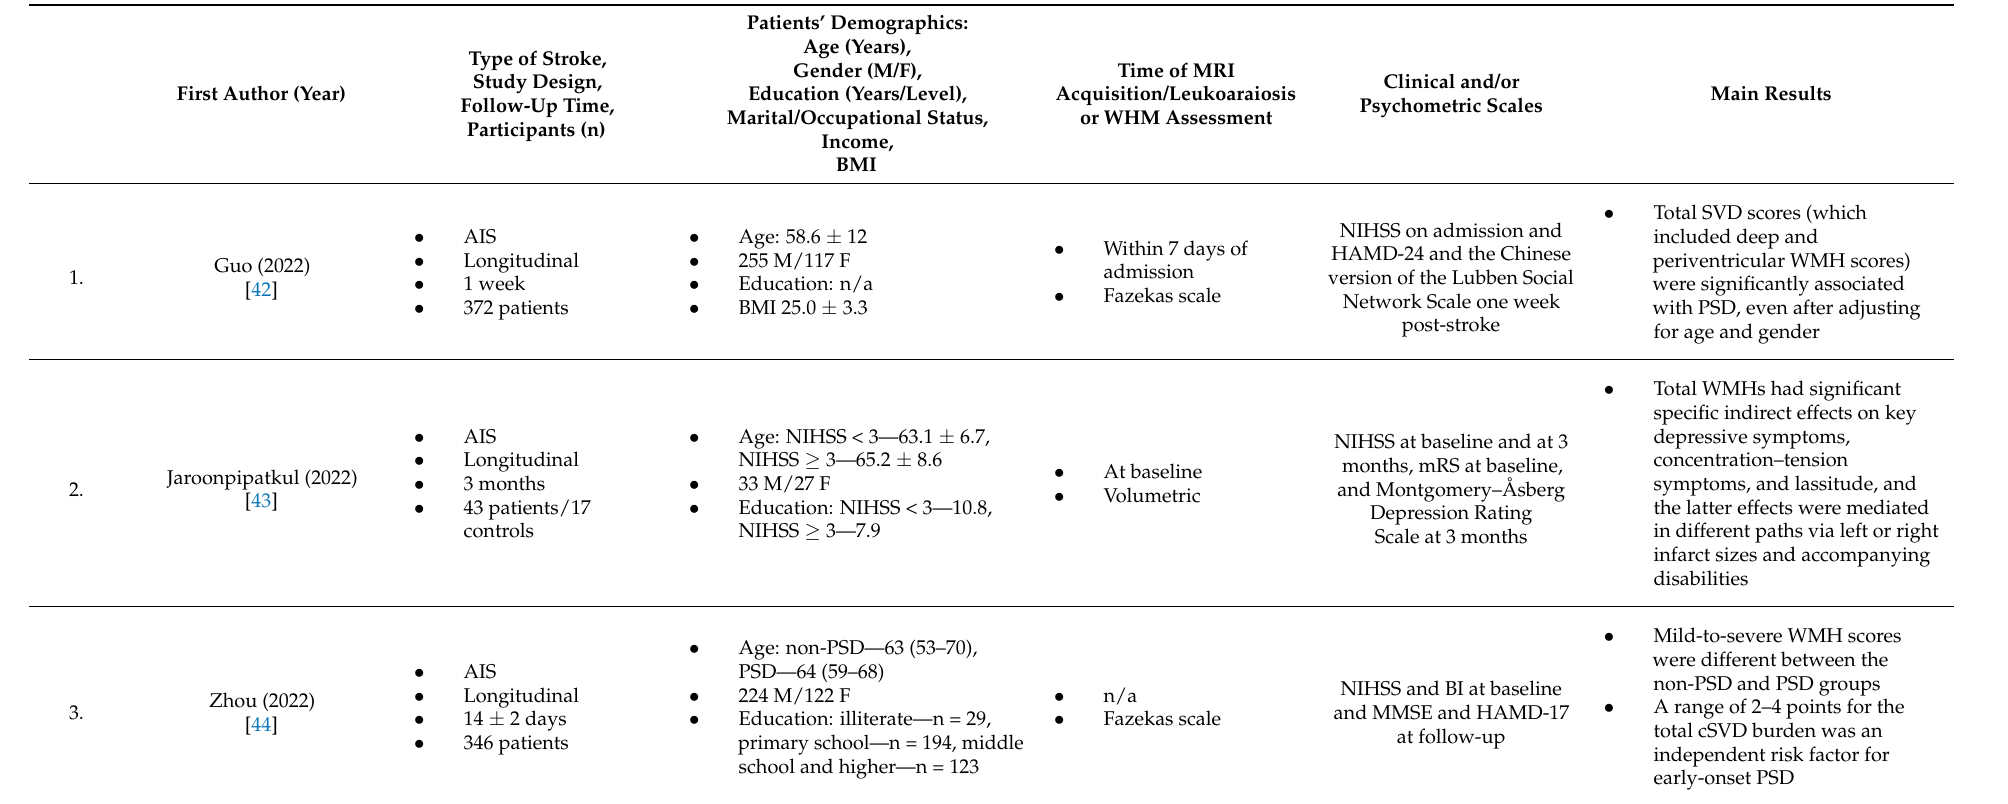
Table 2. Characteristics of the included studies focusing on